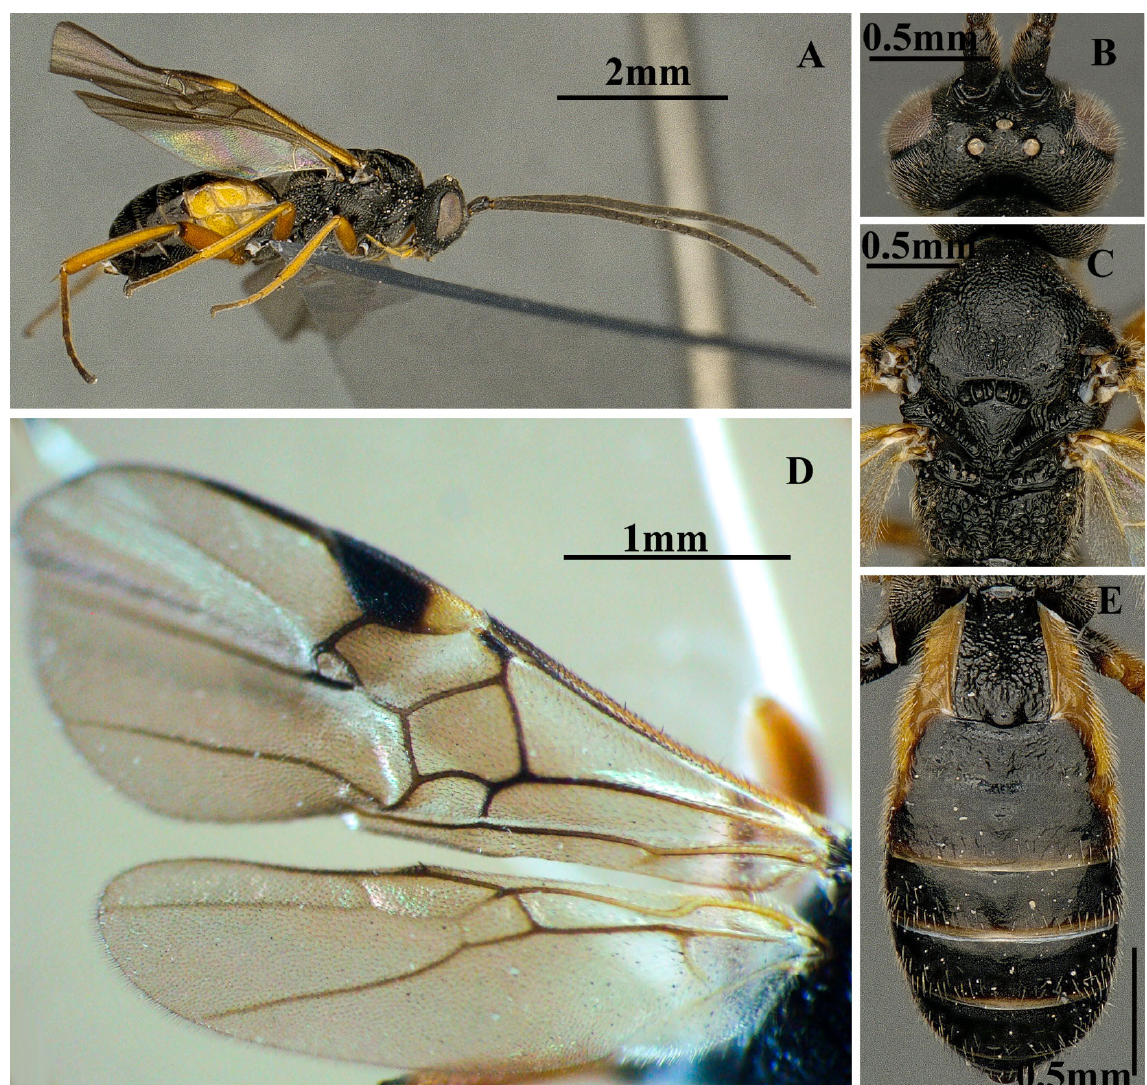
Fig. 12. Microplitis spinolae (Nees, 1834), ♀, TMUC-HBMMP0321. A . Habitus, lateral view. B . Head, dorsal view. C . Mesosoma, dorsal view. D . Wings. E . metasoma, dorsal